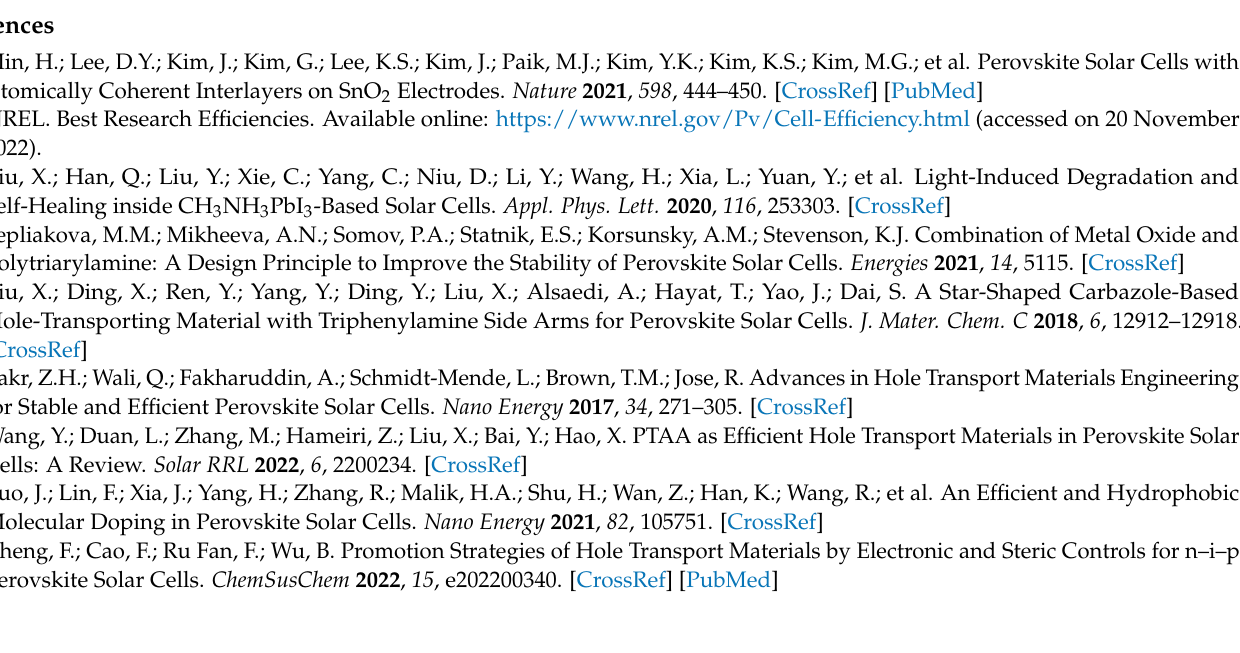
Figure S5: FT-IR spectra of polymers P1 – P3 ; Figure S6: DSC curves for polymers P1 – P3 ; Figure S7: XRD patterns of thin films of conjugated polymers P1 – P3 ; Figure S8: Absorption spectra of polymers P1 – P3 in 1,2-dichlorobenzene solution and thin films (a–c) and temperature- dependent UV-visible absorption spectra for P1 – P3 in 1,2-dichlorobenzene solution (d–f); Figure S9: SEM (top) and AFM (bottom) images for perovskite/HTMs bilayer stacks: MAPbI 3 / P1 (a); MAPbI 3 / P2 (b); MAPbI 3 / P3 (c); Figure S10: Contact angle measurement of a water droplet of placed on the surface of the polymer films; Figure S11: Optical images of glass substrates covered with polymers P1 (a), P2 (b), and P3